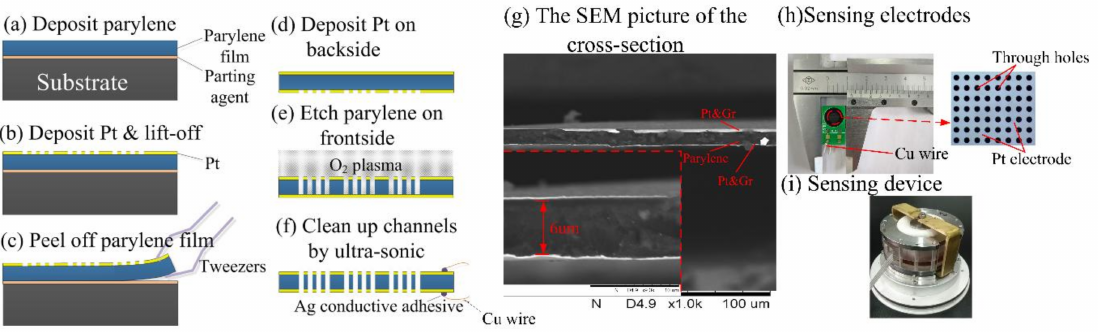
Figure 3. ( a – f ) The fabrication process of the sensing electrodes. ( a ) The parylene was deposited on a reusable substrate. ( b ) The porous platinum (Pt) electrodes were formed on the parylene layer using the lift-off technology. ( c ) The parylene film was peeled away from the substrate. ( d ) Pt sputtering on the other side of the parylene film. ( e ) The parylene film was etched through by oxygen plasma from the front side. ( f ) The suspended Pt electrodes with the beneath parylene etched away were removed by the ultra-sonic cleaning. ( g ) SEM picture of the cross section of the fabricated electrodes. The thickness of the parylene based insulating layer was quantified as 6.7 µ m. ( h − i ) The flexible electrodes and the assembled electrochemical seismic sensor.